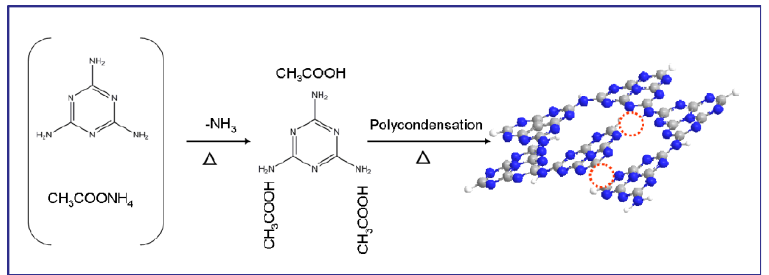
Figure 1. Schematic diagram of the generative process of N D -g-C 3 N 4 .